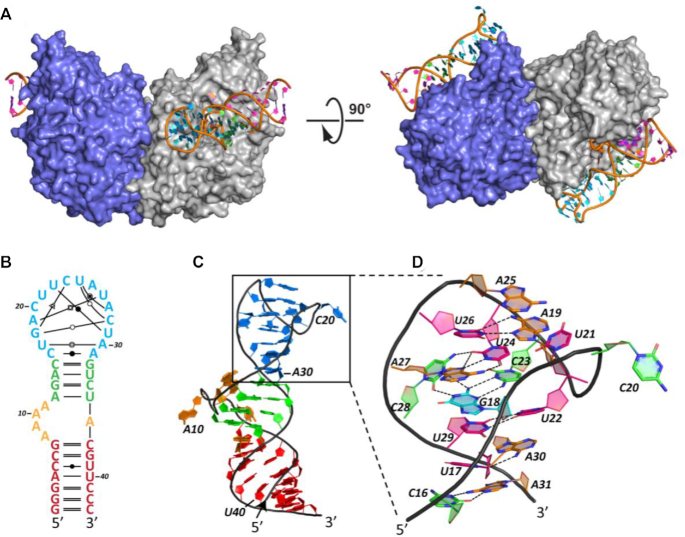
Experimentally determined structure of PSMA-bound A9g aptamer. (A) Overall structure of the PSMA/A9g complex. PSMA homodimer is shown in surface representation with individual monomers colored blue and gray, respectively. A9g binds PSMA with the 1:1 stoichiometry. (B) Schematic representation of A9g adopting a simple step-loop fold that can be divided into four parts – S1 stem (7 nucleotides; red), 4 × 1 L1 loop (adenines A8-A11 on the 5′ strand and A36 on the 3′ strand; orange), S2 stem (4 nucleotides; green) and the L2 hairpin loop (C16 through A31; blue). The noncanonical base pairing in the L2 loop was assigned by RNApdbee (86) and denoted cis Watson–Crick Watson–Crick, trans Watson–Crick Watson–Crick, trans Watson–Crick Hoogsteen, cis Watson–Crick Hoogsteen, trans Hoogsteen Watson–Crick, trans Sugar Watson–Crick. (C) 3D structure of A9g (color-coding as in panel B). The sharp turn of RNA backbone of the L1 loop causes flipping of the four adenines out from the helical core. (D) Detailed view of the 3D arrangement of the L2 loop. Network of eight noncanonical base pairs plays a crucial role in stabilization of the hairpin loop conformation upon PSMA binding.